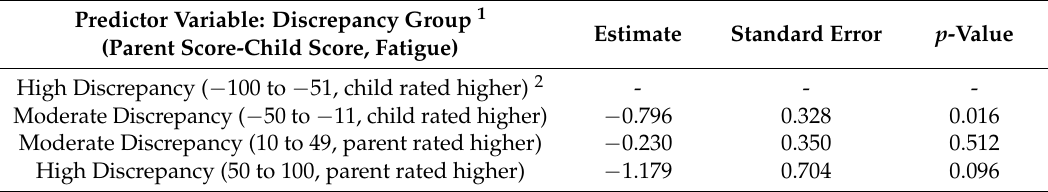
Table 6. Relationship between simple difference of fatigue scores activity limitation. Predictor Variable: Discrepancy Group